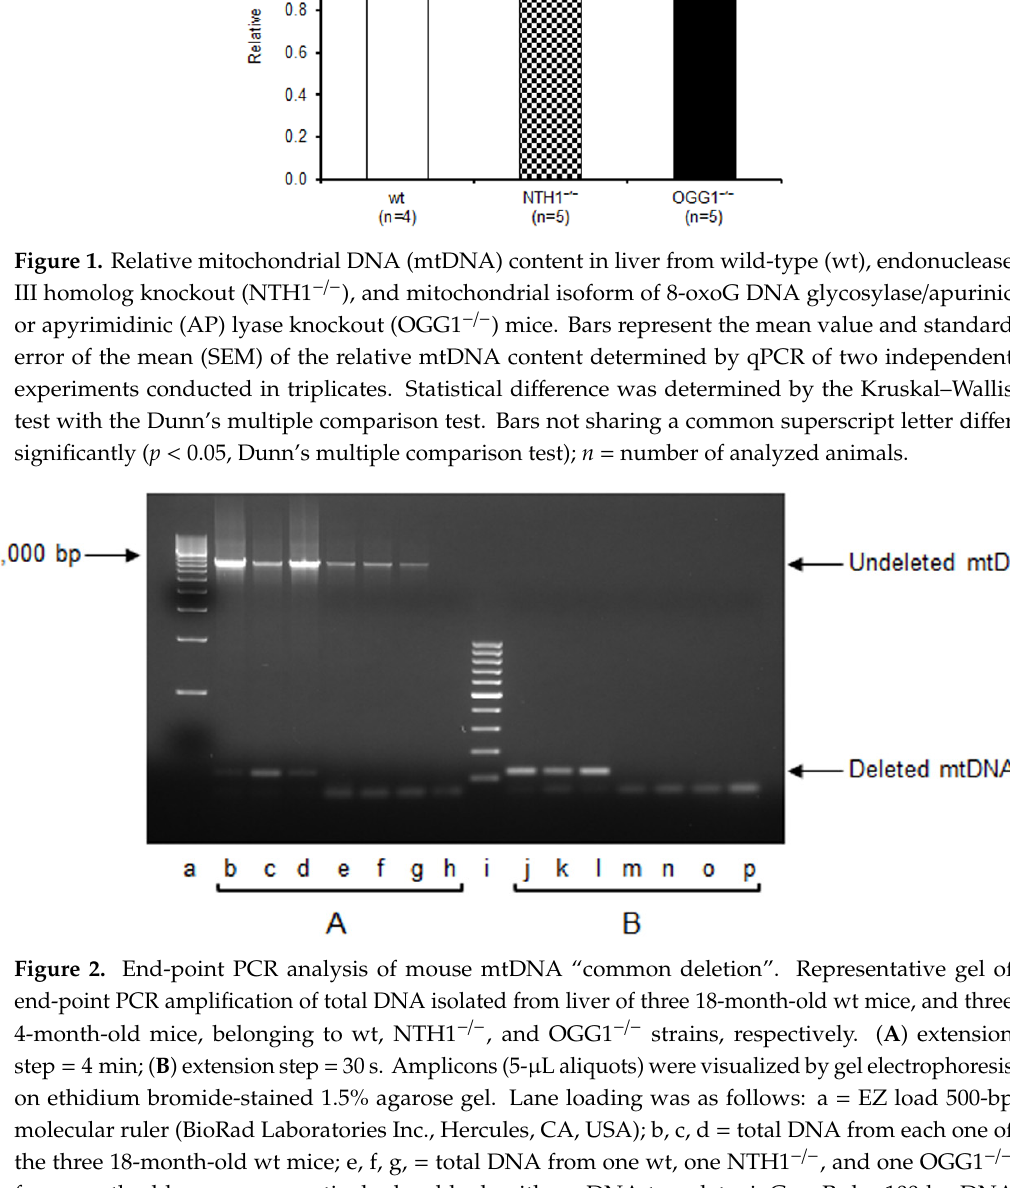
Figure 1. Relative mitochondrial DNA (mtDNA) content in liver from wild-type (wt), endonuclease III homolog knockout (NTH1 − / − ), and mitochondrial isoform of 8-oxoG DNA glycosylase/apurinic or apyrimidinic (AP) lyase knockout (OGG1 − / − ) mice. Bars represent the mean value and standard error